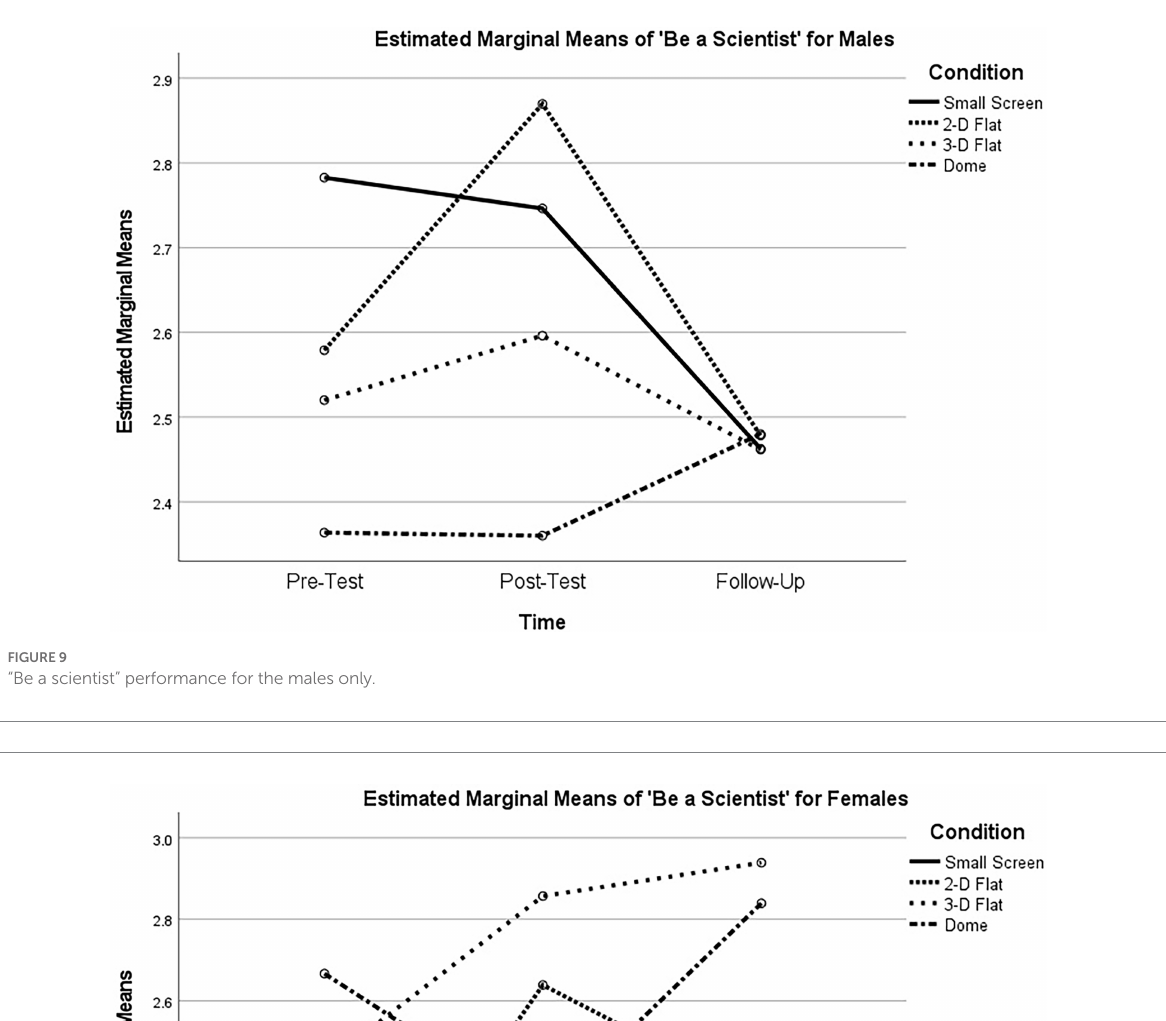
FIGURE 9 “Be a scientist” performance for the males only.